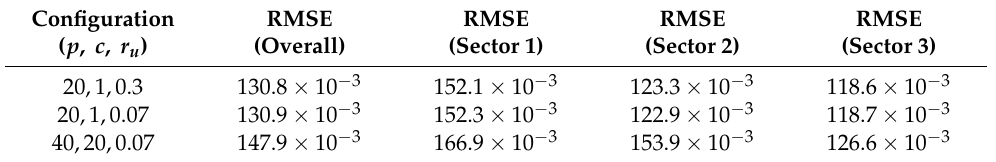
Table 1. RMSE for Test 1.